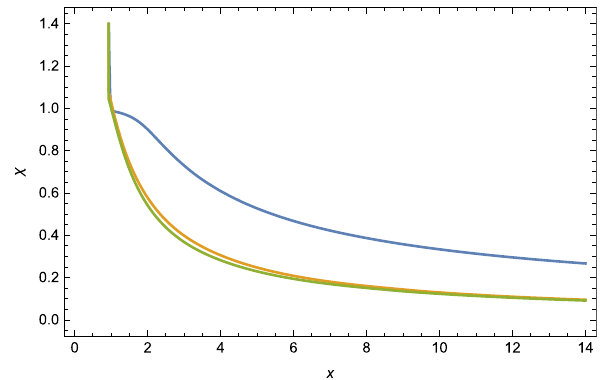
Fig. 2 Case 1. Surface potential p for a pair ( j c , a r ) is function of the anisotropy parameter ϑ . Blue line ( 0 . 1 , 1 . 0 ) , Orange line ( 0 . 1 , 2 . 0 ) , green line ( 1 . 0 , 1 . 0 ) , red line ( 1 . 0 , 2 . 0